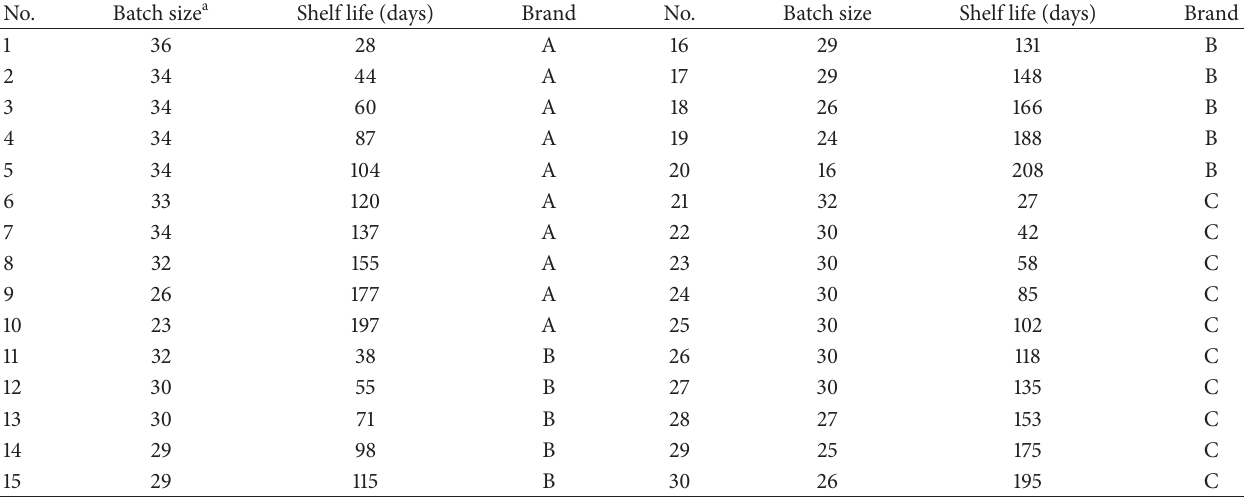
Table 1: The analyzed pidan